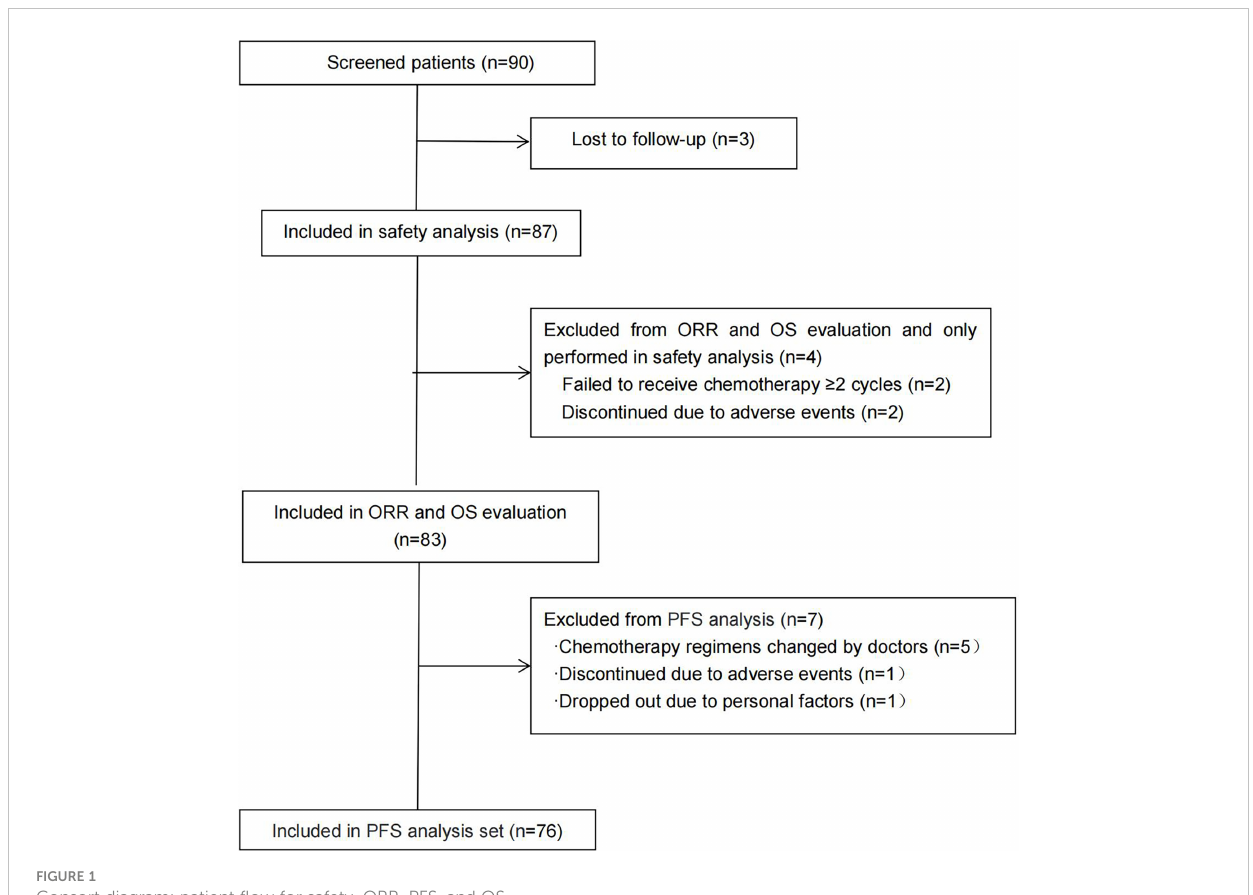
FIGURE 1 Consort diagram: patient fl ow for safety, ORR, PFS, and